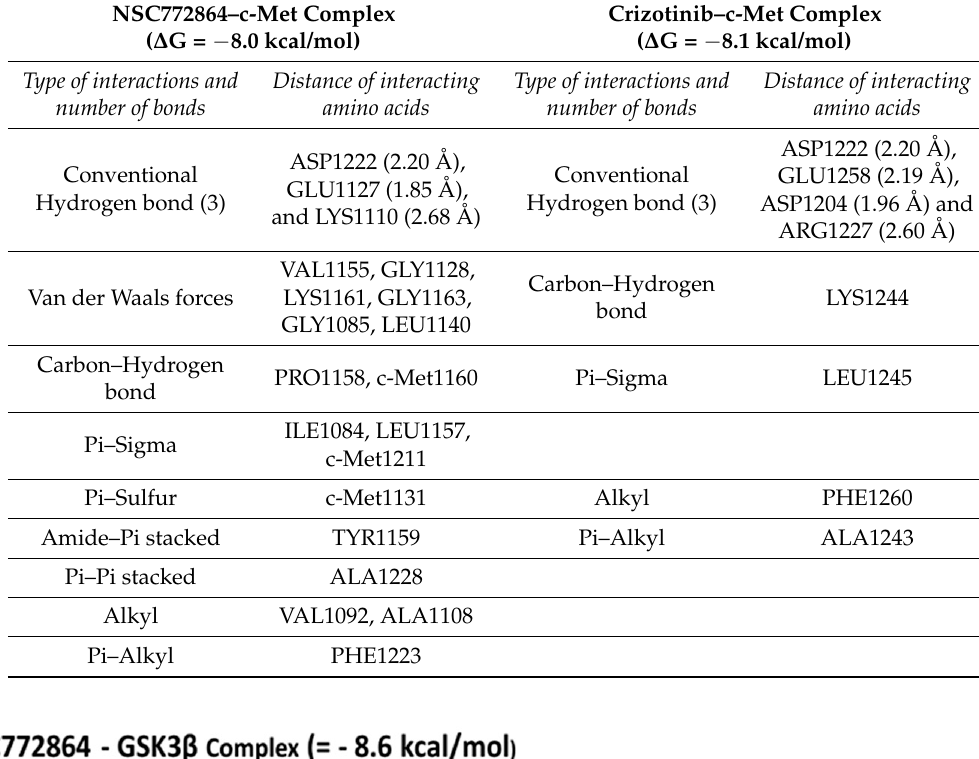
Table 3. NSC772864 and standard drug comparative docking profiles against c-Met.